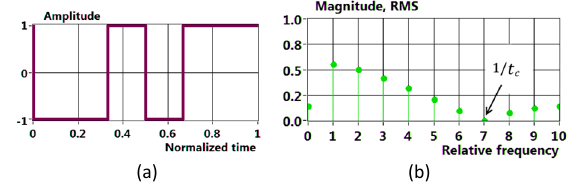
Fig.9: Waveform of the 3-rd order MLBS (a) and its magnitude spectrum